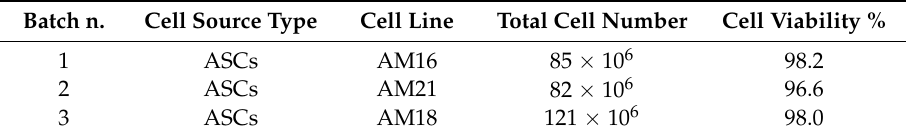
Table 1. Lyo-secretome batches